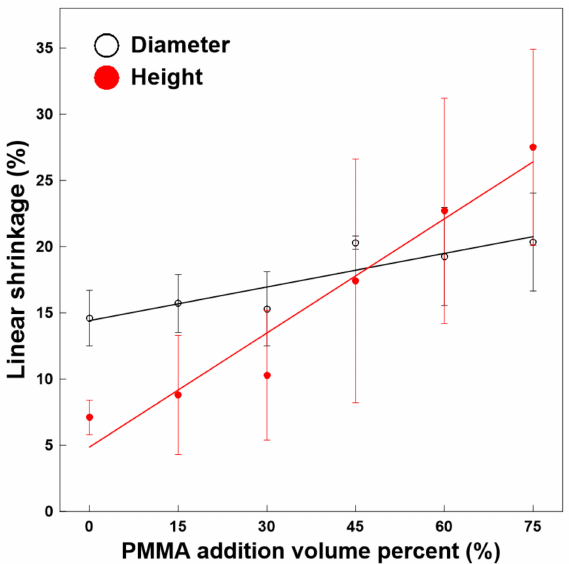
Figure 3. Linear shrinkage for each diameter and height of the sca ff olds; the paired t -test for di ff erence between height shrinkage and diameter was carried out and p < 0.001.